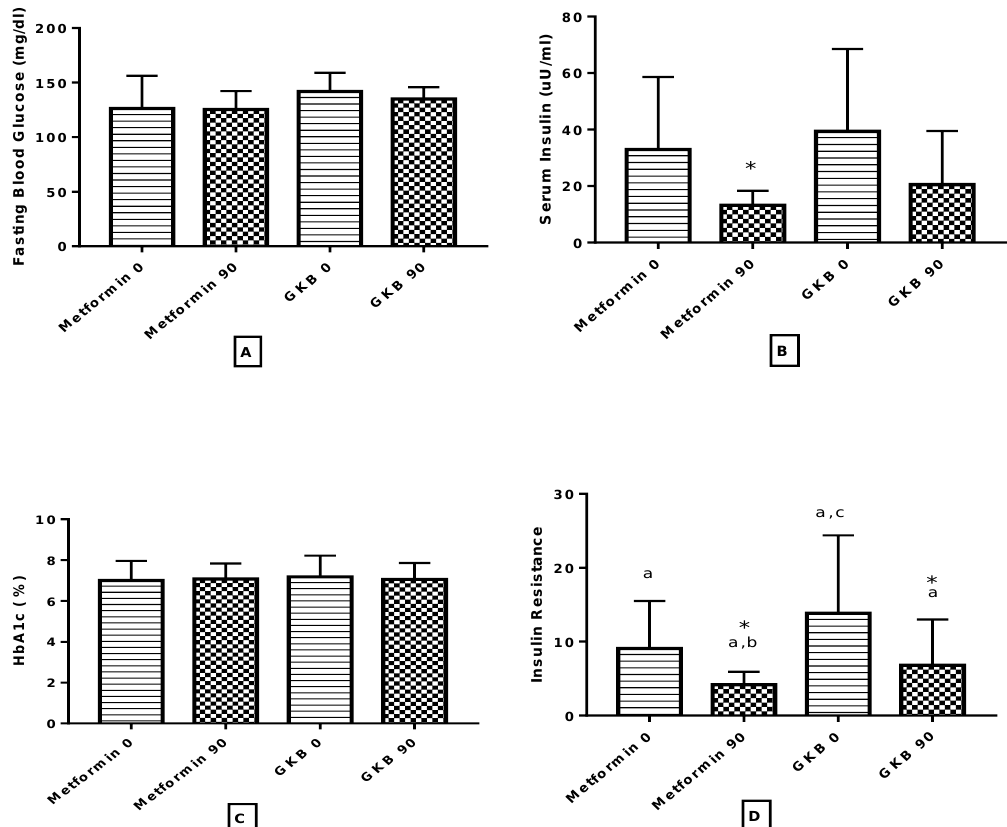
Figure 2 : Effect of Gingko biloba extract (GKB) on the serum level of (A) Fasting Glucose (B) Insulin (C) HbA1c (D) Insulin Resistance of patients with metabolic syndrome. Values were presented as mean ± S.D; * significantly different compared with baseline values (paired t -test, P <0.05). Values with non-identical letters (a, b, c) were significantly different among each other (ANOVA, P <0.05). Table 1. Baseline characteristics of the randomly allocated metabolic syndrome patients Parameters